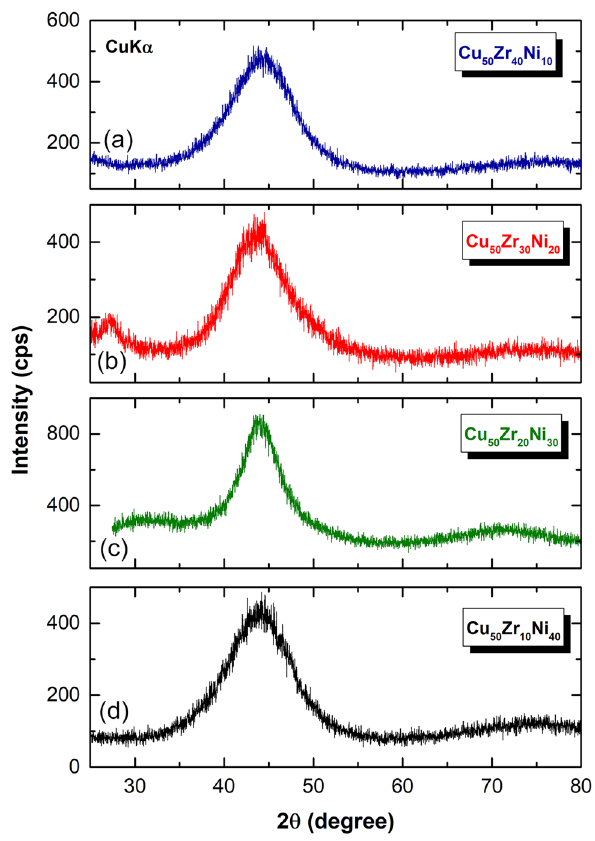
Figure 6. XRD patterns of ( a ) Cu 50 Zr 40 Ni 10 , ( b ) Cu 50 Zr 30 Ni 20 , ( c ) Cu 50 Zr 20 Ni 30 , and ( d ) Cu 50 Zr 20 Ni 30 powders obtained after 50 h of MA time. All the samples without exceptions revealed halo-diffuse patterns, implying the formation of amorphous phase.